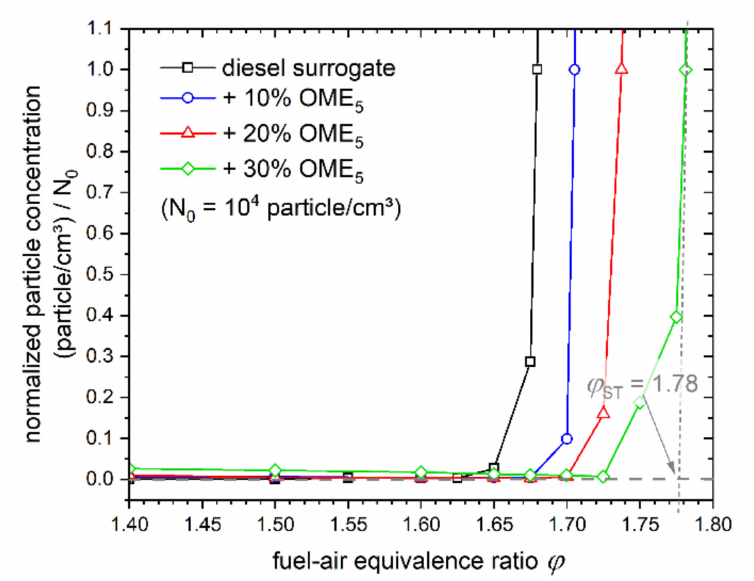
Figure 4. Normalized particle concentrations for the diesel surrogate and the surrogate-OME 5 mixtures (percentage given in mass fraction) showing the extrapolation to the soot threshold ( ϕ ST ). The grey dashed tangent line indicates the maximum gradient of the increasing particle concentration for the mixture of the diesel surrogate with 30% ( w / w ) OME 5 and is extrapolated to the base line where the intersection gives the value for ϕ ST